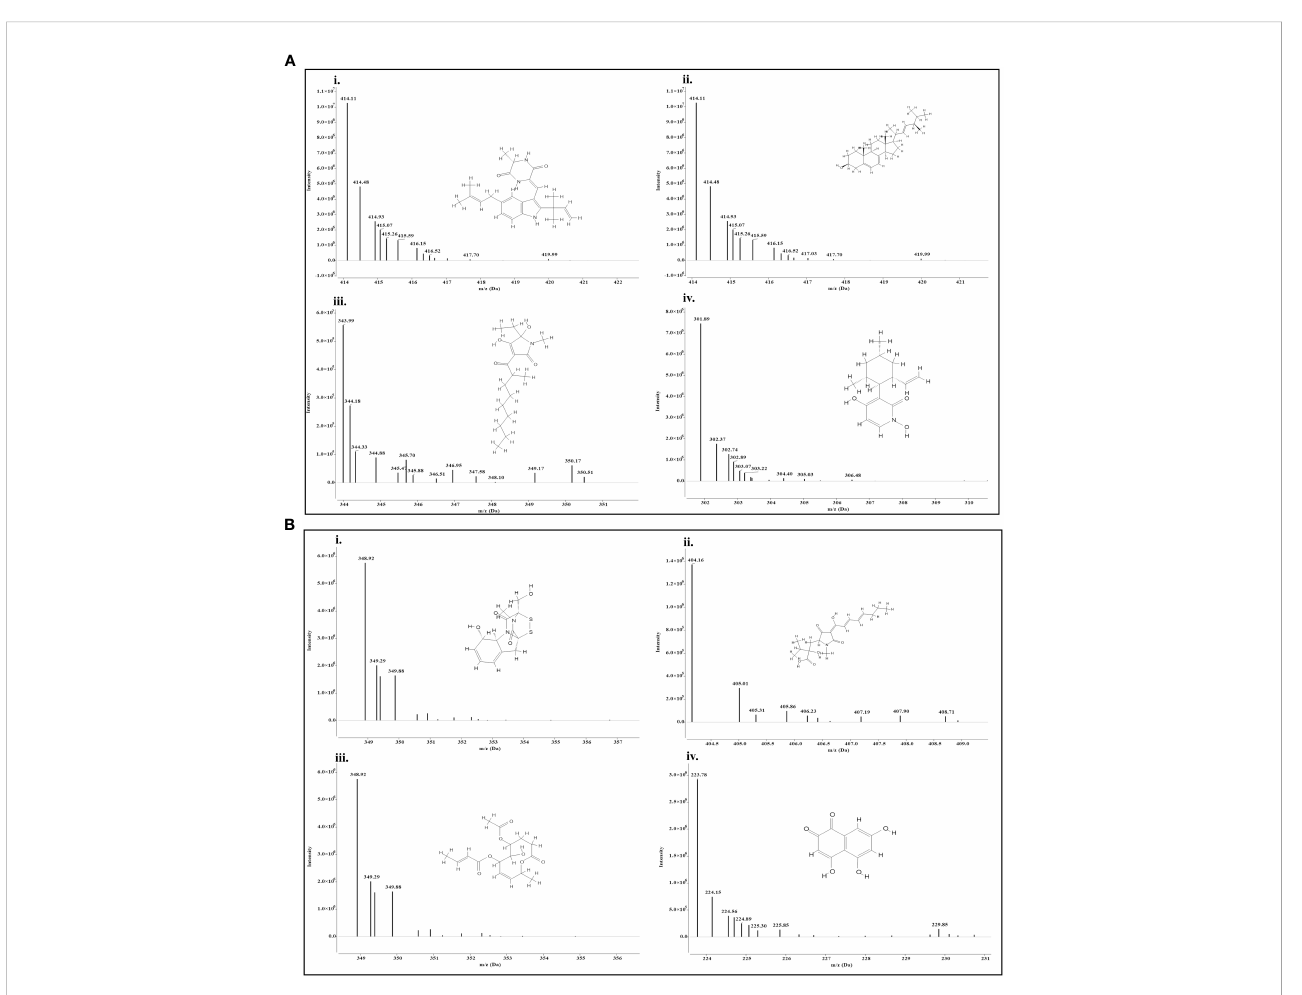
FIGURE 10 Mass spectra and chemical structure of four abundantly found antimicrobial compounds in (A) Trichoderma harzianum NBG - i) Isoechinulin A, ii) Ergosterol, iii) Coprogen D, and iv) Pyridoxatin. (B) Trichoderma harzianum NBG - i) Gliotoxin, ii) Harzianic acid, iii) Cremenolide D, and iv)